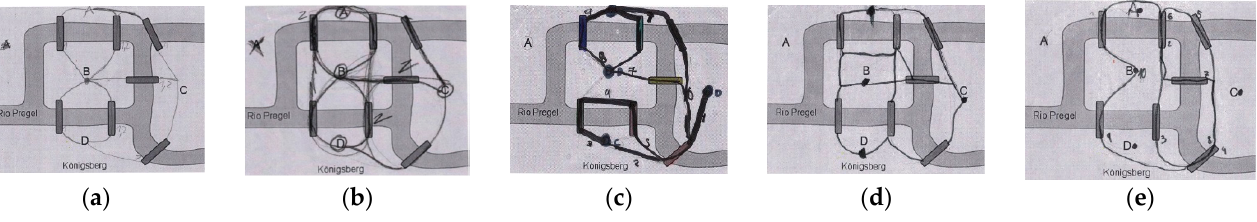
Figure 11. Köningsberg bridges. Drawing made by participant: ( a ) A7; ( b ) A6; ( c ) A5; ( d ) A3; ( e ) A4.